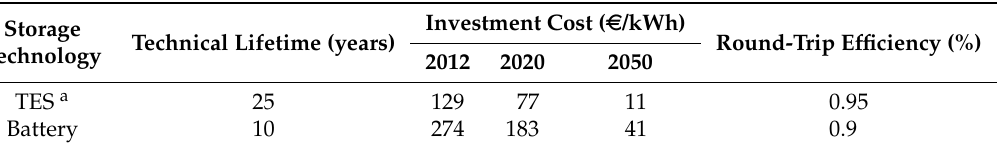
Table A4. Base input data and assumptions for storage technologies available for investment in the ELIN model. The cost curves used in the model are fitted from these